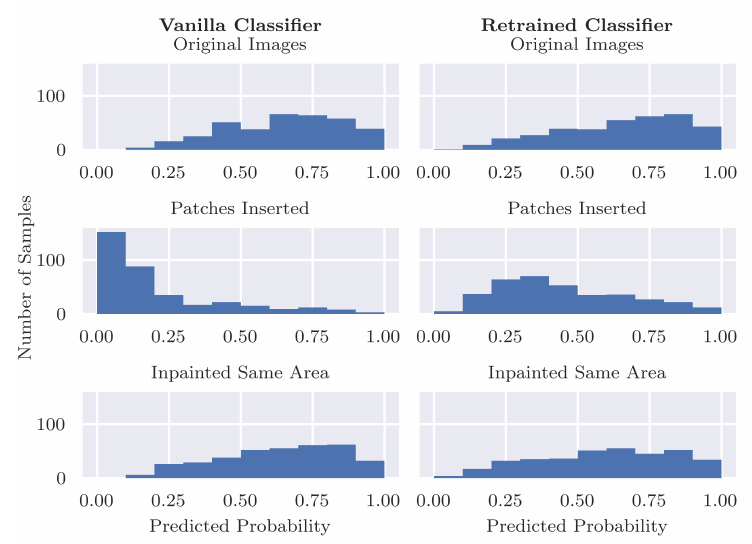
Figure 7. Predicted P ( malignant | x ) for original malignant images, after inserting patches, and after inpainting the same area that the patch covers. The probability distribution for the inpainted images is closer to that of the original images rather than the images with inserted patches.